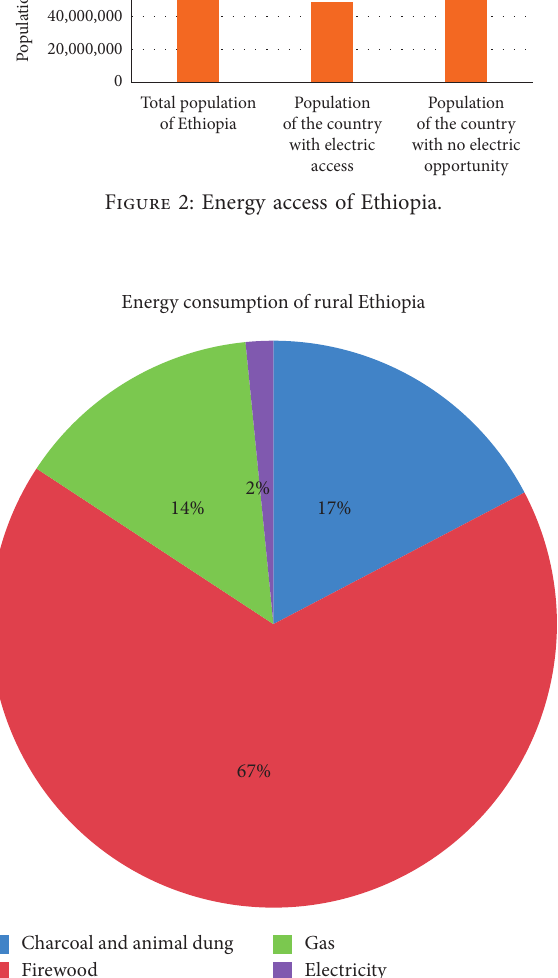
Figure 3: Energy consumption of rural area in Ethiopia.